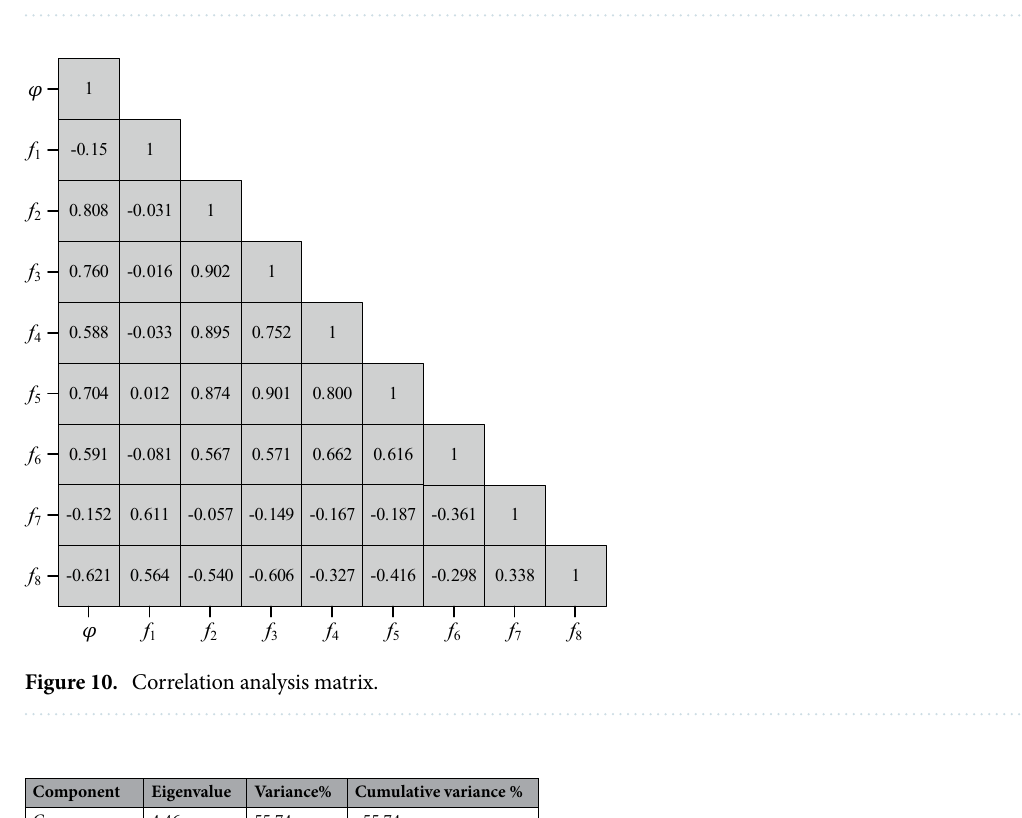
Figure 9. Product structural robustness under random attacks and FKC.